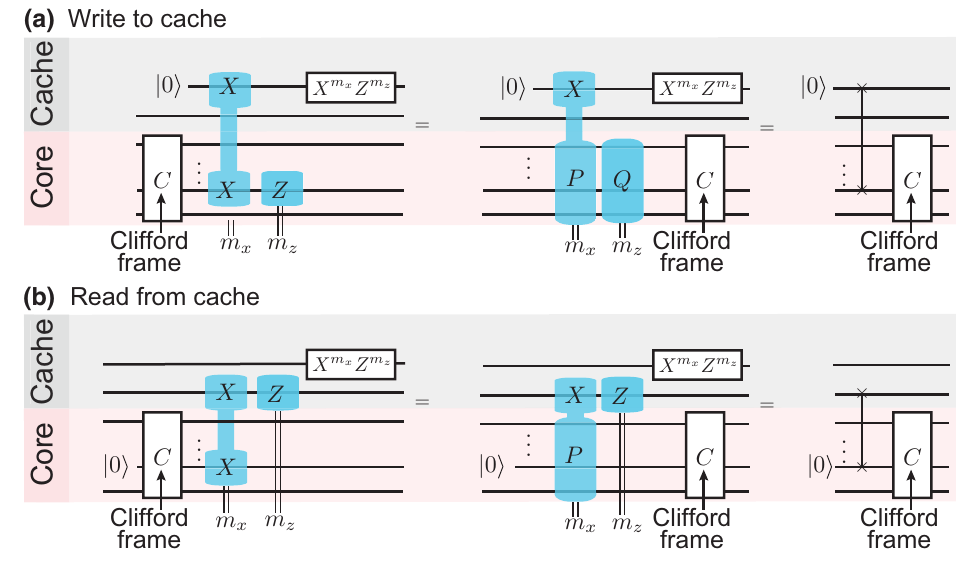
FIG. 16. Circuit diagrams for the operations (a) write to cache (WTC) and (b) to read from cache